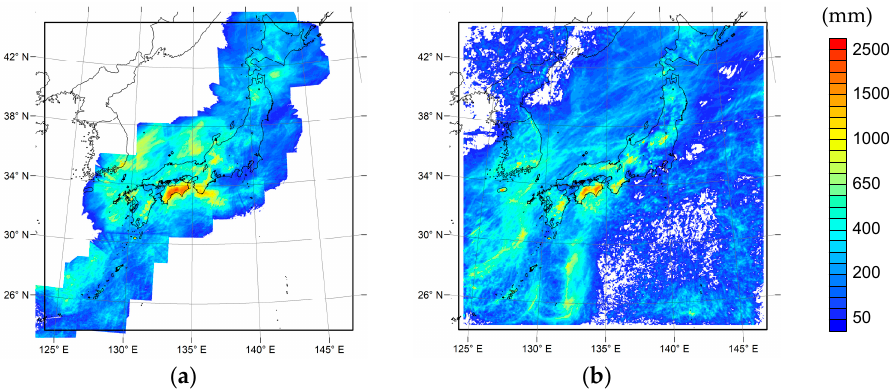
Figure 4. Spatial distributions of monthly precipitation in August 2014 obtained from ( a ) Radar/Raingauge-Analyzed Precipitation data and ( b ) W_5km case. The Radar/Raingauge-Analyzed Precipitation data covers areas within a few hundred kilometers from the coastal lines of Japan.